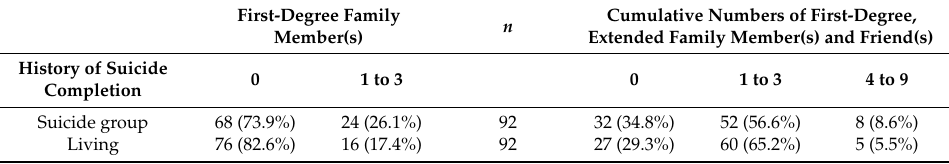
Table 5. History of suicide completion among first-degree family members and